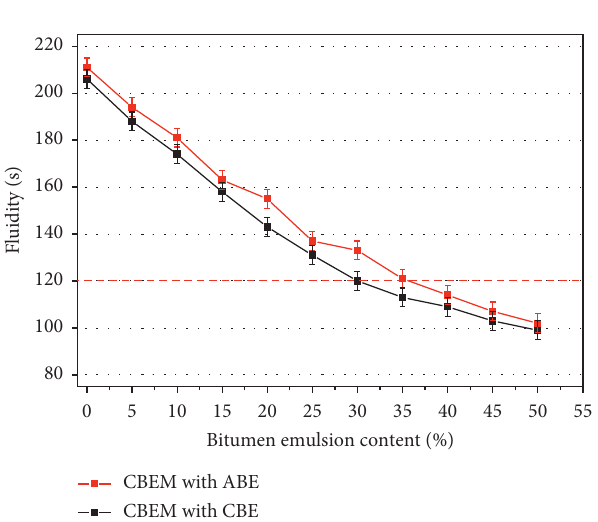
Figure 2: Influences of bitumen emulsion content on CBEM fluidity.